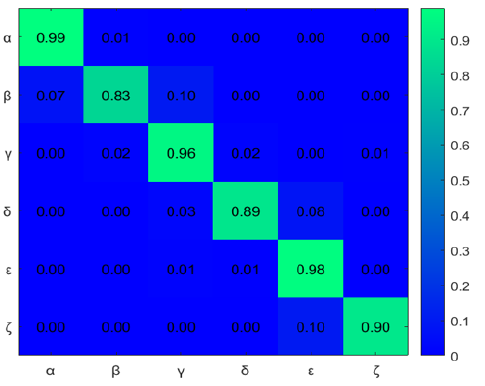
Figure 15. Joint transition probability matrix from the initial model.